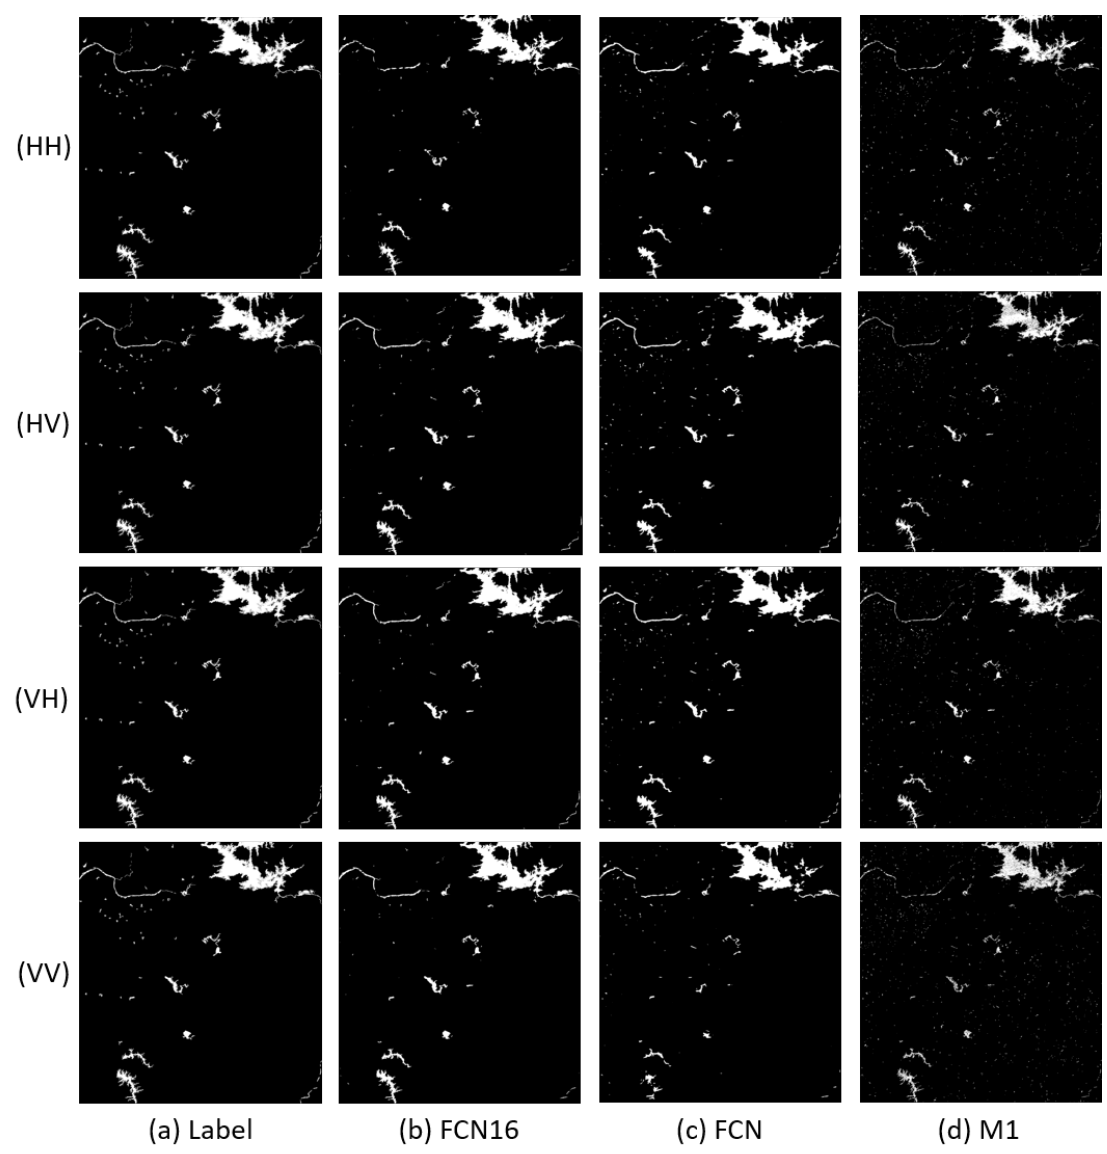
Figure 7. Results comparison of Scene 3: ( a ) Label; ( b ) FCN16; ( c ) FCN; and ( d )